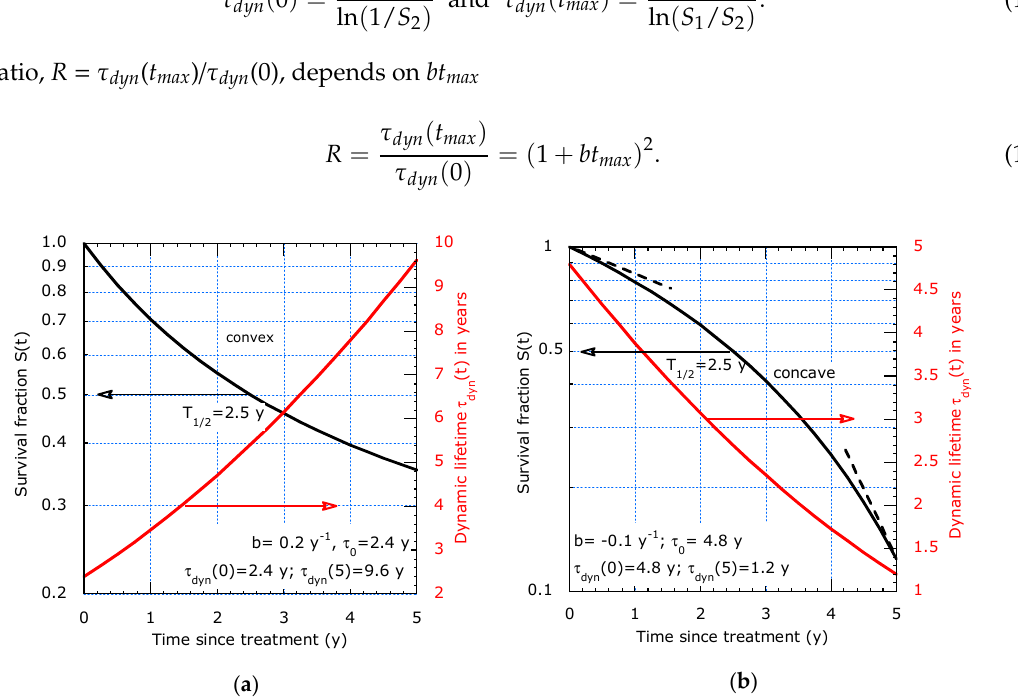
Figure 3. Survival (left scale) and dynamic lifetime (right scale) example of the sliding- τ model: ( a ) Filtering out of defects (convex curve): b = 0.2 y -1 and τ dyn (0) = 2.4 y, τ dyn (5) = 9.6 y; ( b ) Accelerated aging (concave curve): b = -0.1 y -1 , τ dyn (0) = 4.8 y and τ dyn (5) = 1.2 y.